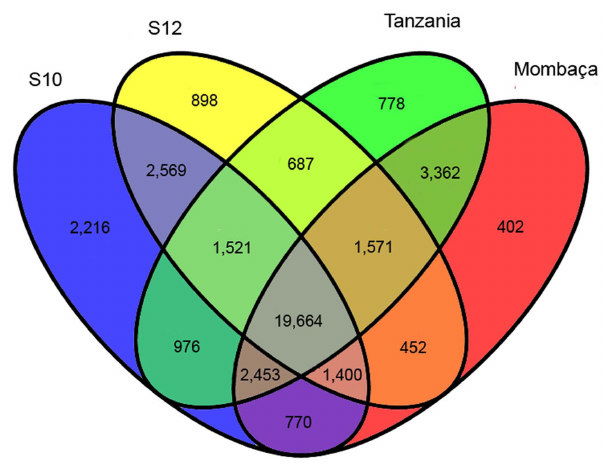
Figure 3. Shared and unique unigenes of Panicum maximum determined based on RSEM analysis.